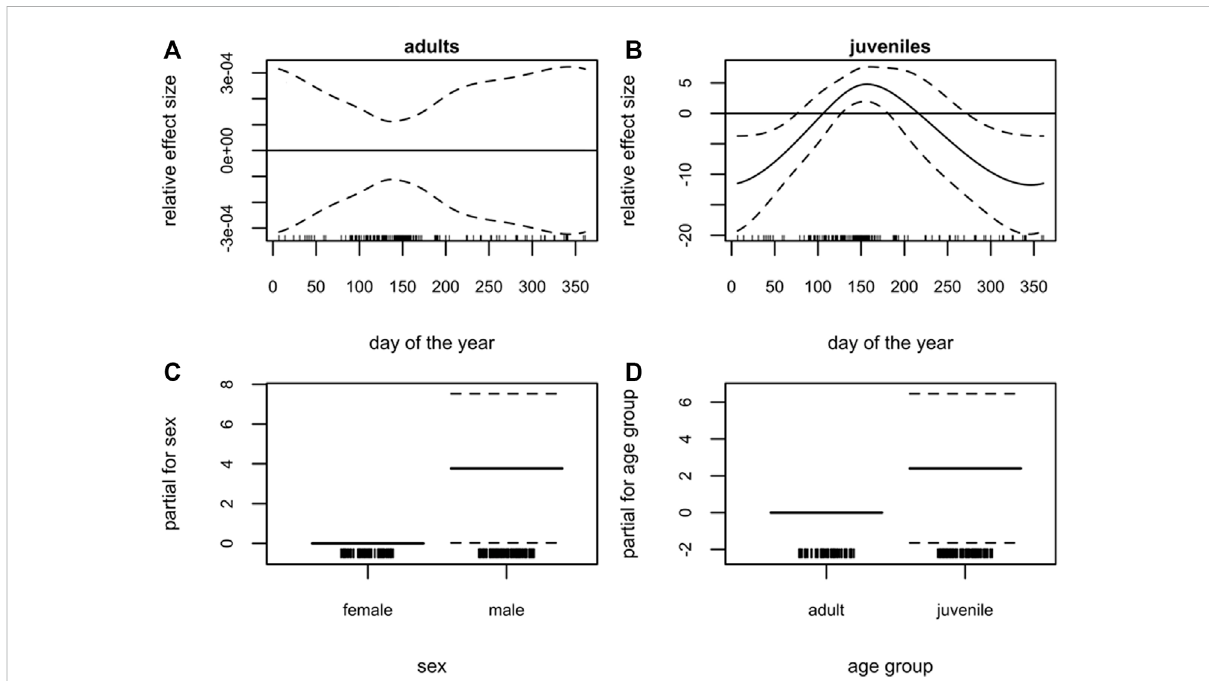
FIGURE 3 Grey seal ( Halichoerus grypus ), South-western Baltic Sea. Generalized additive model (GAM) of grey seal blubber thickness showing the seasonal dependency (day of theyear 1 – 365) conditional on age group (A) adults, (B) juveniles (present and previous years ’ offspring). Moreover, the parametric terms of (C) sex and (D) age group. The y -axes represent the term ’ s spline function (solid line). Zero on the y -axes corresponds to no effect of the predictor variable. The dotted lines re fl ect two times the SE bands (i.e., 95% con fi dence interval). Hatch marks on the x -axes show sample values and ranges. Deviance explained = 11.9%, n =